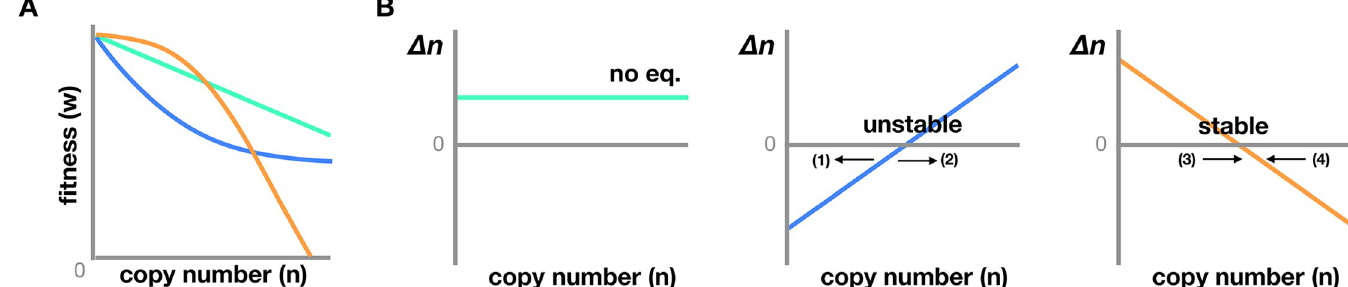
Fig 3. Impacts of the epistatic interactions among TEs’ deleterious effects on TEs’ population dynamics. (A) Three possible models for the interactions among TEs’ deleterious effects: additive (green), multiplicative (blue), and synergistic (orange) models (reviewed in [54]). (B) The per-generation change in TE copy number ( Δ n) under these models when the transposition rate of TEs holds constant. Theories predict that Δ n is determined by the rate of TE replication (increases copy number) and the rate of changes in host fitness (decreases copy number by selection against TEs’ deleterious effects) [69]. Additive model: When the deleterious effects of TEs are independent, host fitness is determined by summing the effects of individual TE in the host genome. In this case, host fitness declines linearly with respect to TE copy number (green in A), and the rate of fitness change with every additional TE holds constant (the slope of green line in A). Unless the rate of fitness change is exactly the same as the rate of increase in TE copy number through transposition, no equilibrium could be reached (B left panel). On the contrary, with epistatic interactions among TEs’ deleterious effects (multiplicative or synergistic), the relationship between host fitness and TE copy number is nonlinear, and equilibrium in TE copy number is possible. Multiplicative model: The deleterious effects of TEs weaken with each additional TE in a host genome (blue in A), and the rate of fitness change decreases with increased TE copy number (slope of blue line in A). While TE copy number could reach equilibrium (i.e., when Δ n = 0, B middle panel), this equilibrium is unstable. A slight decrease in TE copy number leads to an even faster decline in TE copy number (arrow [1]) while a slight increase has the opposite effects (arrow [2], B middle panel). Synergistic model: Each additional TE imposes a larger fitness cost than the last TE, and the rate of fitness change escalates with more TEs in a host genome (slope of orange line in A), which accelerates the removal of TEs from the population. A stable equilibrium is possible because slight perturbations always lead back to the equilibrium (arrow [3] and [4], B right panel). TE, transposable